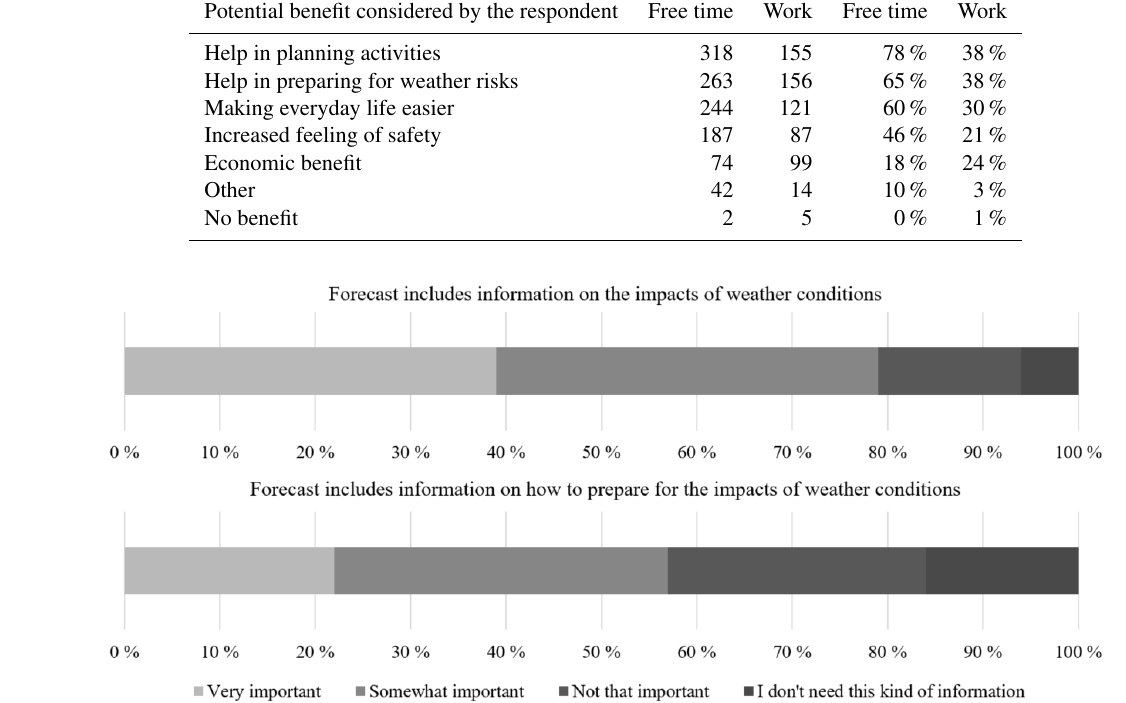
Figure 4. Rated value of built-in impact information compared to preparedness-related information in extended-range